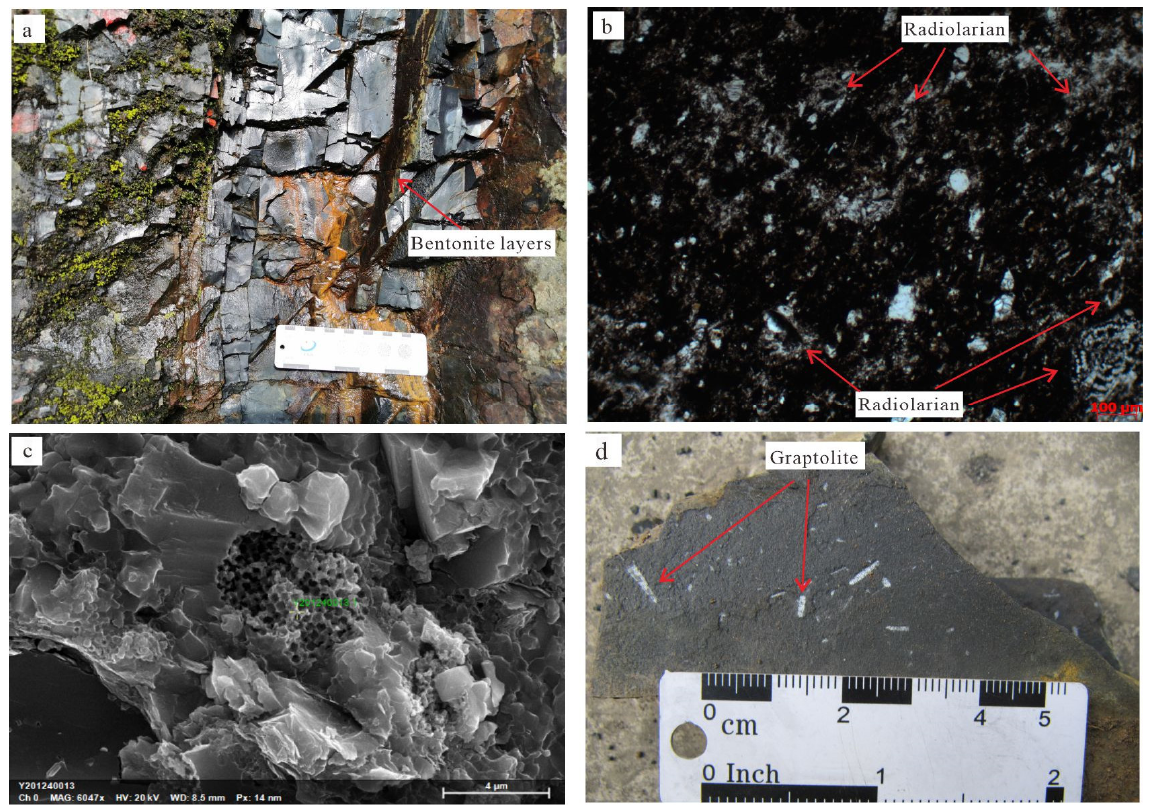
Figure 4. The characteristics of the black shale of the Longmaxi Formation. ( a ) Siliceous rocks in the lower part of longmaxi Formation. ( b ) Radiolarian, thin section characteristics. ( c ) Pyrite framboids, SEM. ( d ) Graptolite photo.